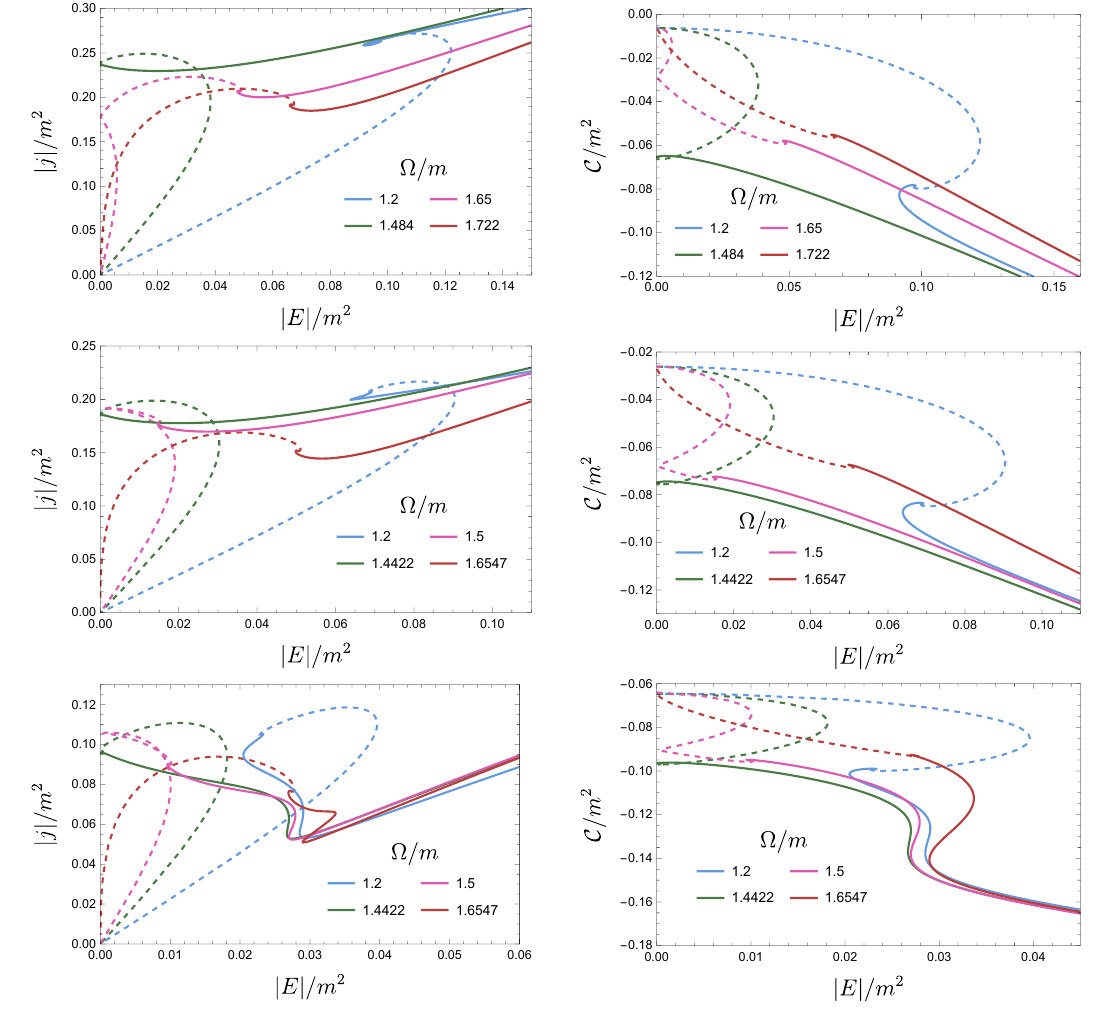
Figure 4 . The dashed curves represent the insulator (Minkowski) phase and the solid curves the conductive (BH) phase (beware the opposite code with respecto to [1]) . Electric current | j | /m 2 and condensate C /m 2 versus electric field for r h /m = 0 . 5 , 0 . 7 and 0 . 84 , from top to bottom. The driving frequency is fixed to some Ω /m < Ω c /m (blue), Ω /m = Ω c /m (green), Ω c /m < Ω /m < Ω m /m (pink) and Ω /m = Ω m /m (red). We show that E can only vanish for j 6 = 0 for Minkowski embeddings with Ω c ≤ Ω ≤ Ω meson